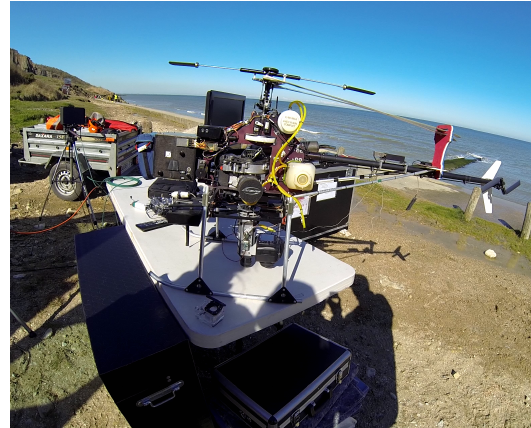
Figure 2. Copter 1B UAV used for the acquisition (Photo : R. Antoine/TeleDeTAC project).